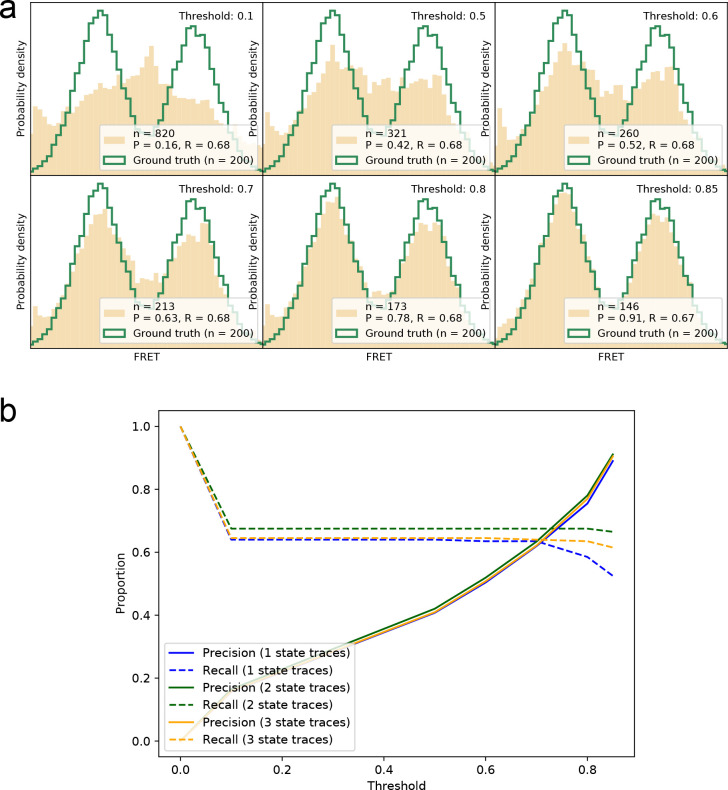
Precision-recall for correctly identifying smFRET traces at different thresholds.(a) Visual display of recovered smFRET distributions for several thresholds for a 2-state system (same data as Figure 2). (b) The precision and recall are calculated for all thresholds on the datasets shown in Figure 2 and Figure 2—figure supplement 2. For 1-, 2-, and 3-state systems we find that a threshold around 0.8–0.9 provides the best trade-off between the two measures, in order to recover the underlying FRET distribution faithfully.